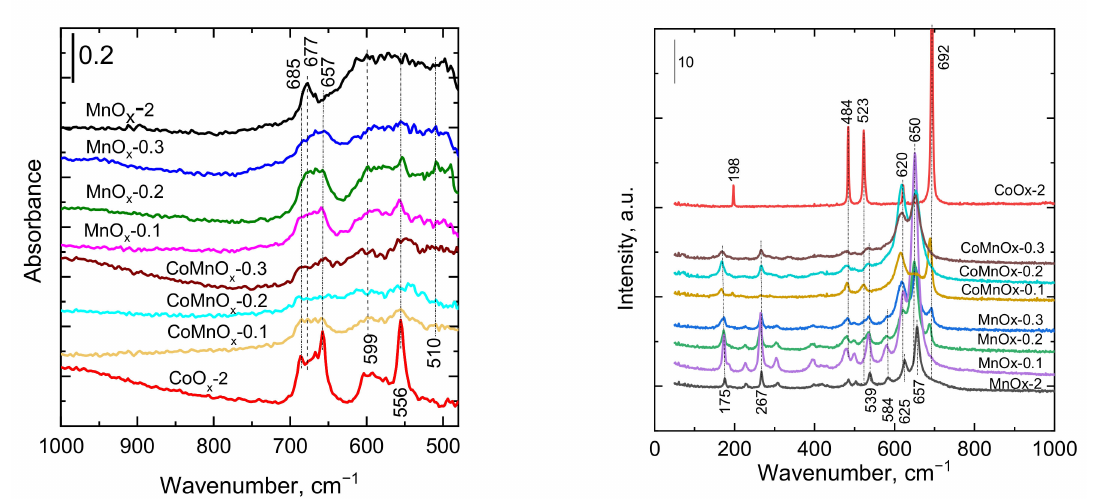
Figure 5. FTIR ( left ) and Raman ( right ) spectra of the